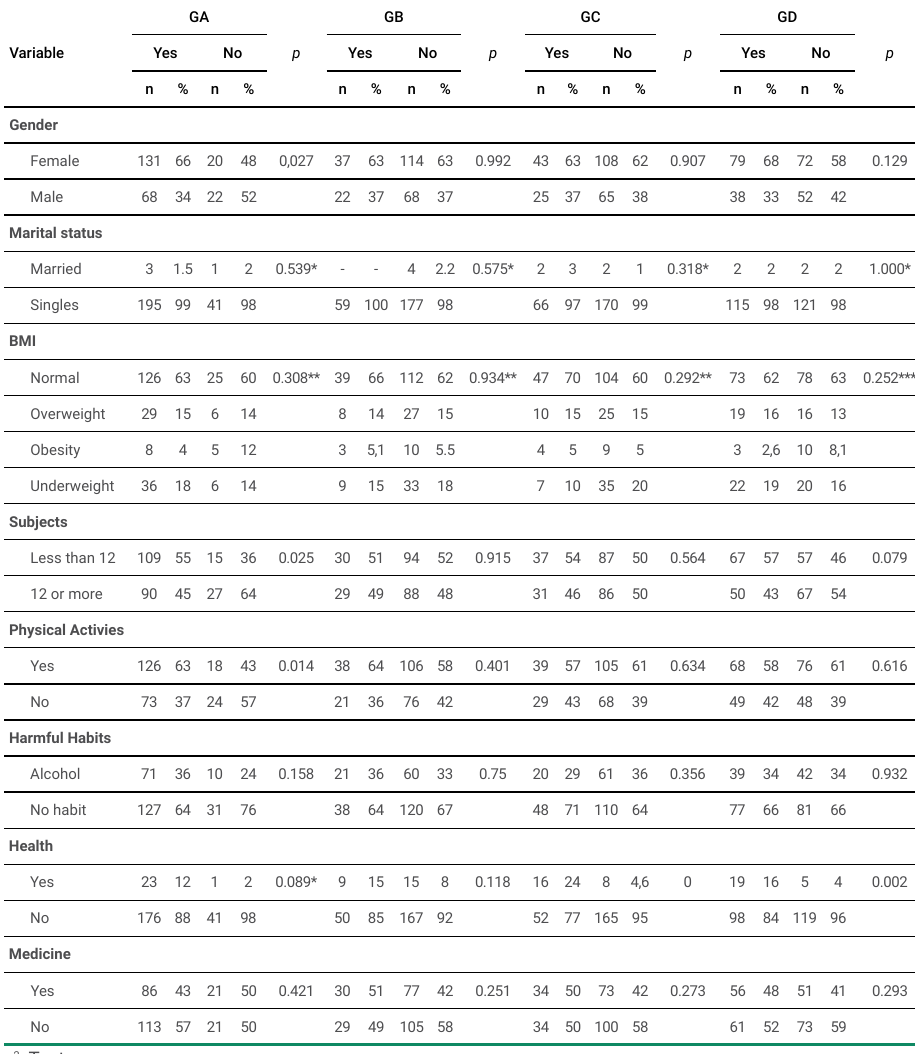
Table 4. Associations between sociodemographic variables and the variables of the Nordic Musculoskeletal Questionnaire. Araçatuba, 2013 .